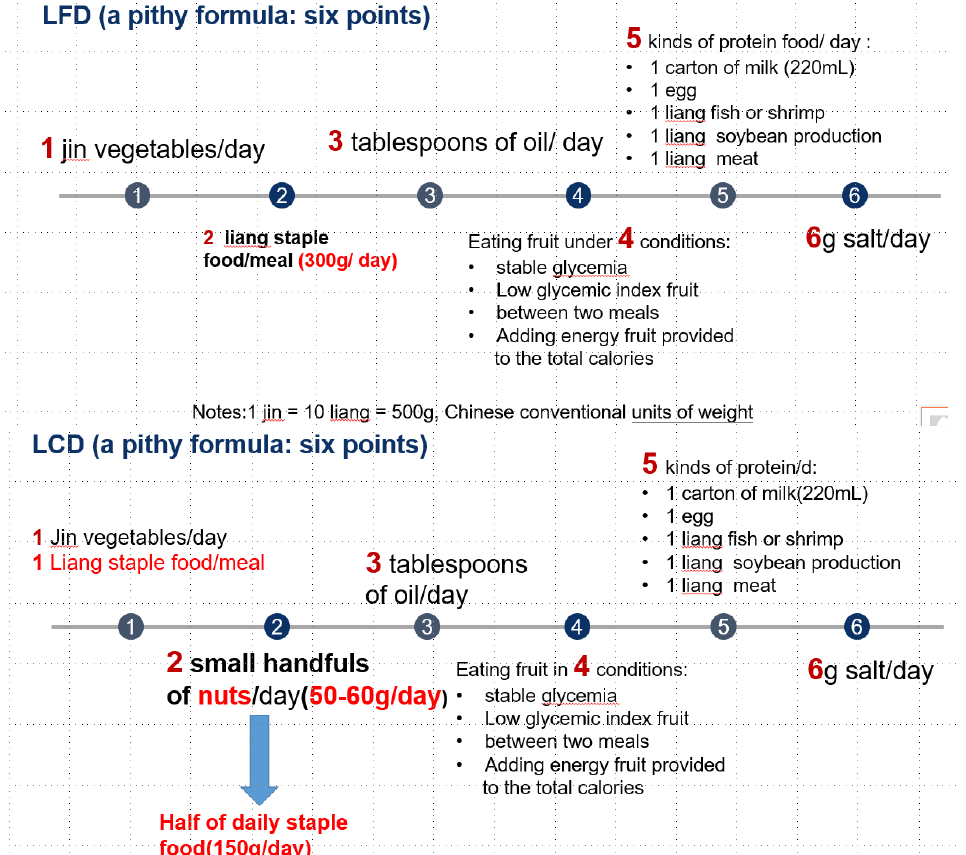
Figure 1. The detailed contents of the six-point formula of two groups. Notes: 1 jin = 10 liang = 500 g, Chinese conventional units of weight. Staple food/meal refers to foods rich in carbohydrates, mainly three kinds of steamed bread, noodles and rice in China. LFD: Low-fat diet; LCD: Low-carbohydrate diet.